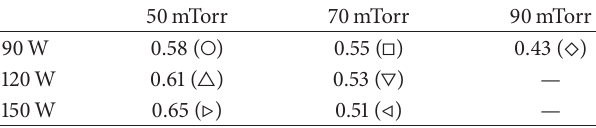
Table 1: Anisotropy factor 𝑓 depending on the etching parameters (pressure and power). Symbols in brackets belong to Figure